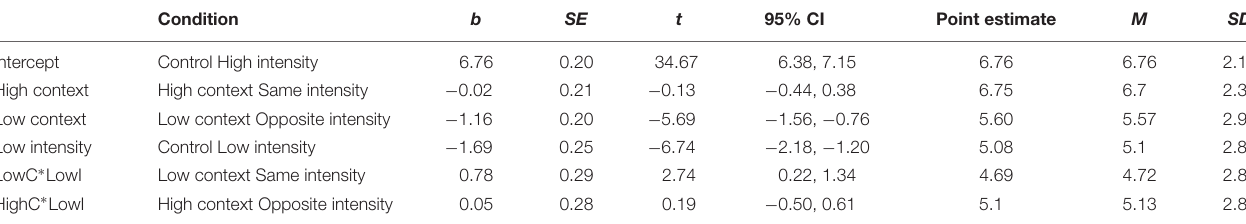
TABLE 2 | Table of the fixed effects factors for the multi-level model of laugh responses for Experiment 2. Condition b SE t 95% CI Point